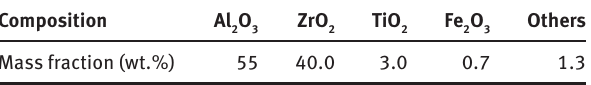
Table 1: Chemical composition of the ceramic particles. Composition Mass fraction (wt.%)